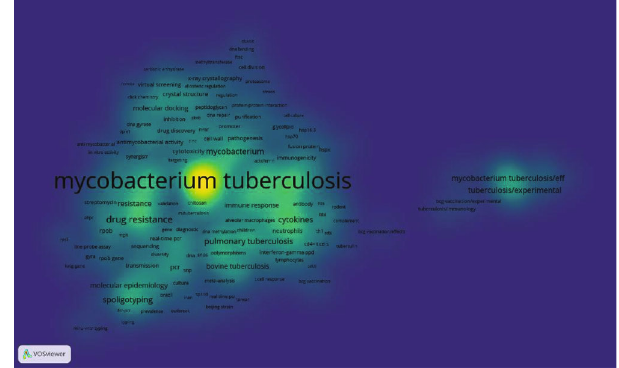
Figure 3: Densities of keywords in the topic “ Clinical symptoms ” in scienti fi c articles on tuberculosis.